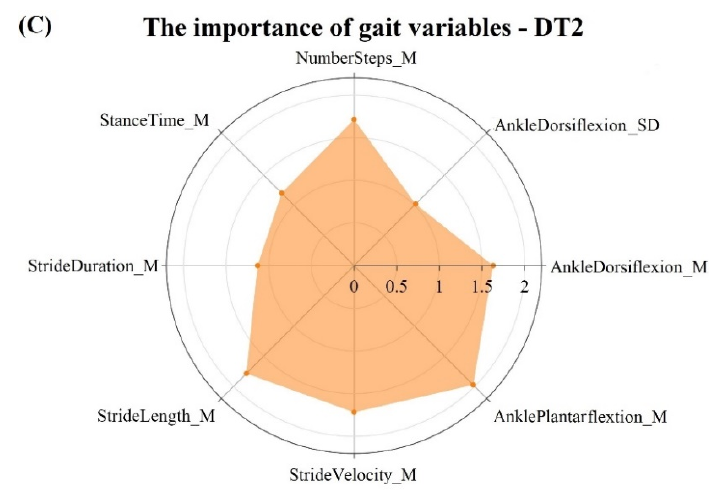
Figure 2. ( A – C ) shows the importance of the gait parameters by orange area (VIP > 1) from ST, DT1, and DT2. M = mean, SD = standard deviation. DT1 = walking and checking boxes on a paper sheet; DT2 = serial 7 s subtraction.